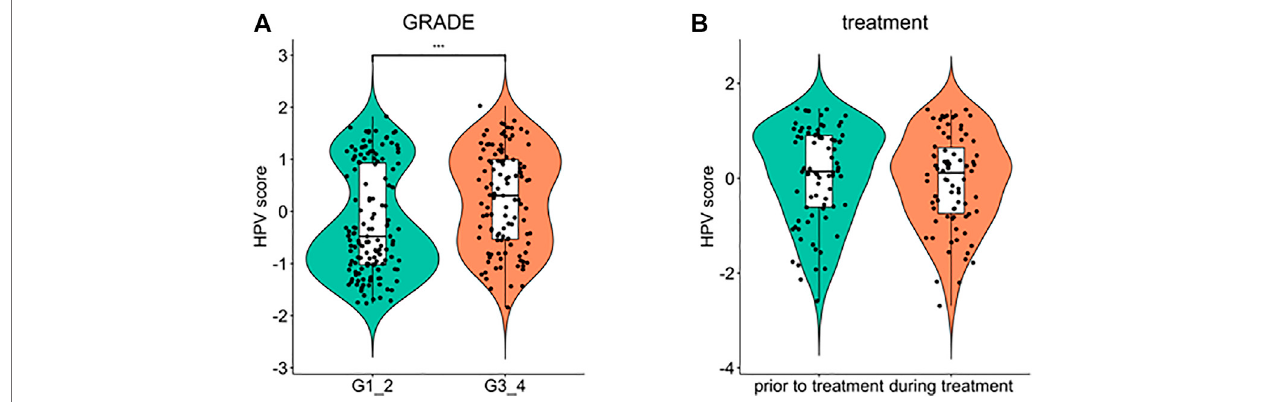
FIGURE 9 | The ROC curve of HPV score for predicting the survival rate of patients with cervical cancer in TCGA database.